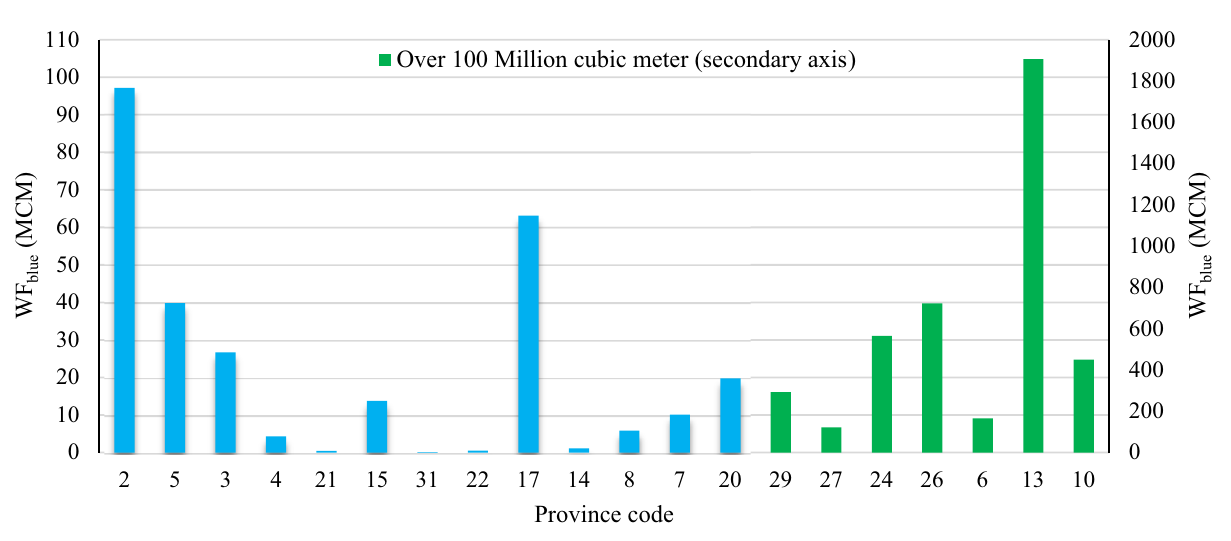
Figure 6. Total water footprints available to modify the cropping pattern by province. Note The province codes refer to the provinces shown on the map in Fig.